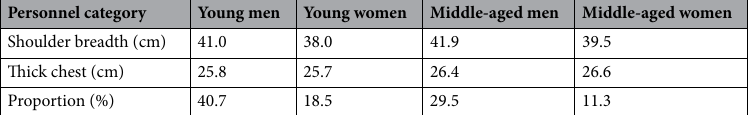
Table 4. Physical sign parameters and proportions of construction personnel.